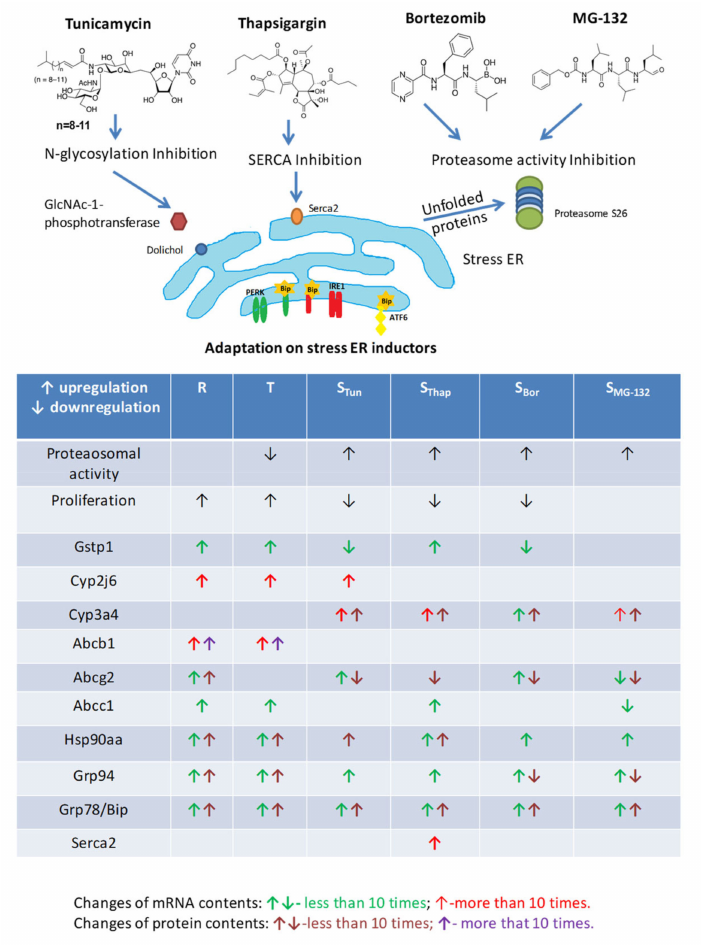
Figure 8. Chemical structures of tunicamycin, thapsigargin, bortezomib and MG-132 and their effects, whichcauseanincreaseincellcontentofunfoldedproteins. StructuresweredrawnusingACD / ChemSketch for academic and personal use (Advanced Chemistry Development, Inc. Toronto, Ontario, Canada). Tunicamycin is an inhibitor of GlcNAc-1-phosphotransferase (GPT), which catalyzes the transfer of N -acetylglucosamine-1-phosphate from UDP- N -acetylglucosamine to dolichol phosphate [24]. It